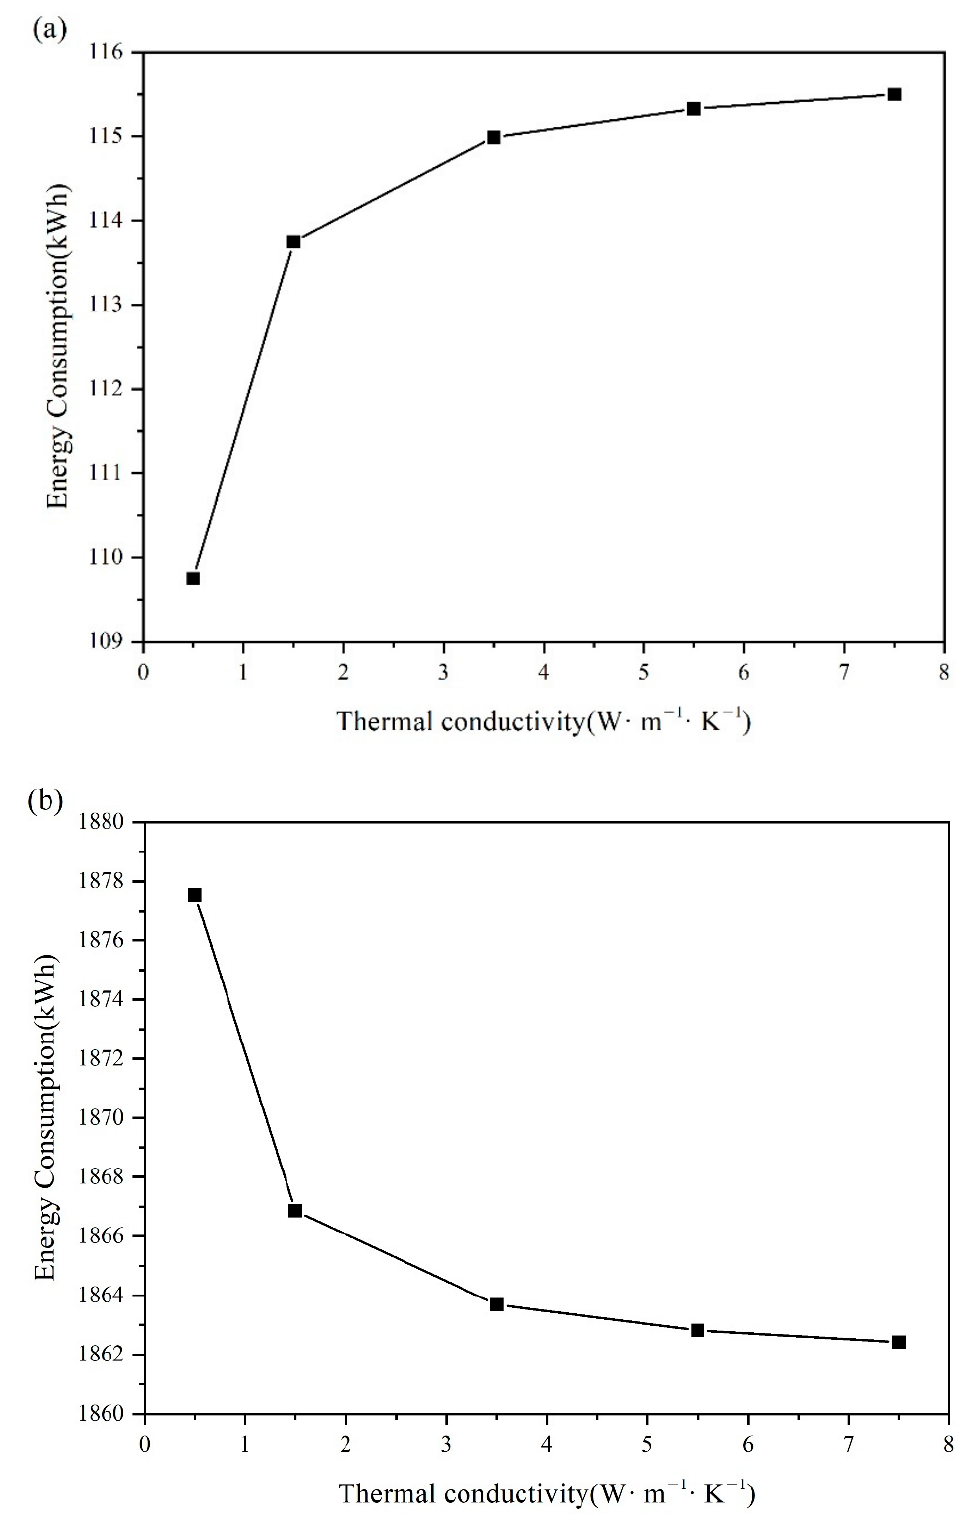
Figure 8. During the ventilated month of ( a ) the roof and ( b ) the south wall, the energy consumption of the room when installing the PCMs with different thermal conductivity on ( a ) the roof and ( b ) the south wall.